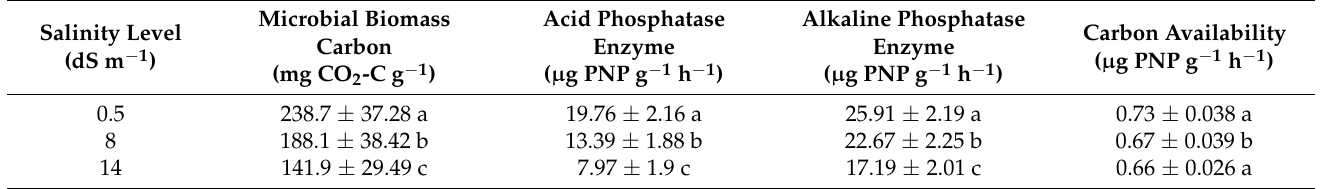
Table 4. The effect of salinity levels on some qualitative indices of the studied soil.